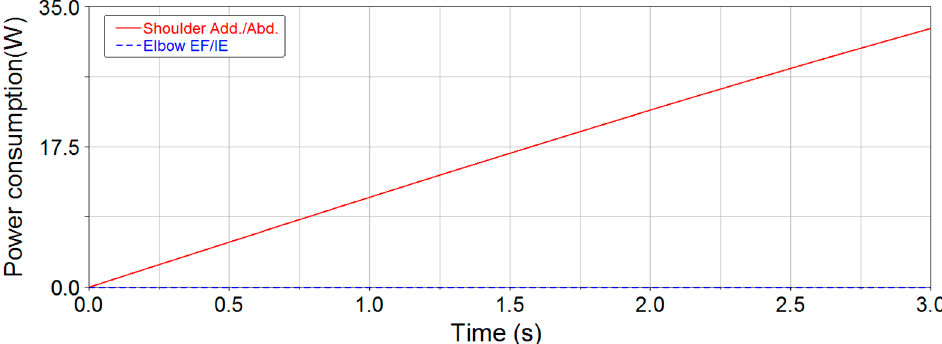
Figure 16. Joint power consumption curves of lateral lifting for the 3 ‐ DOF exoskeleton.